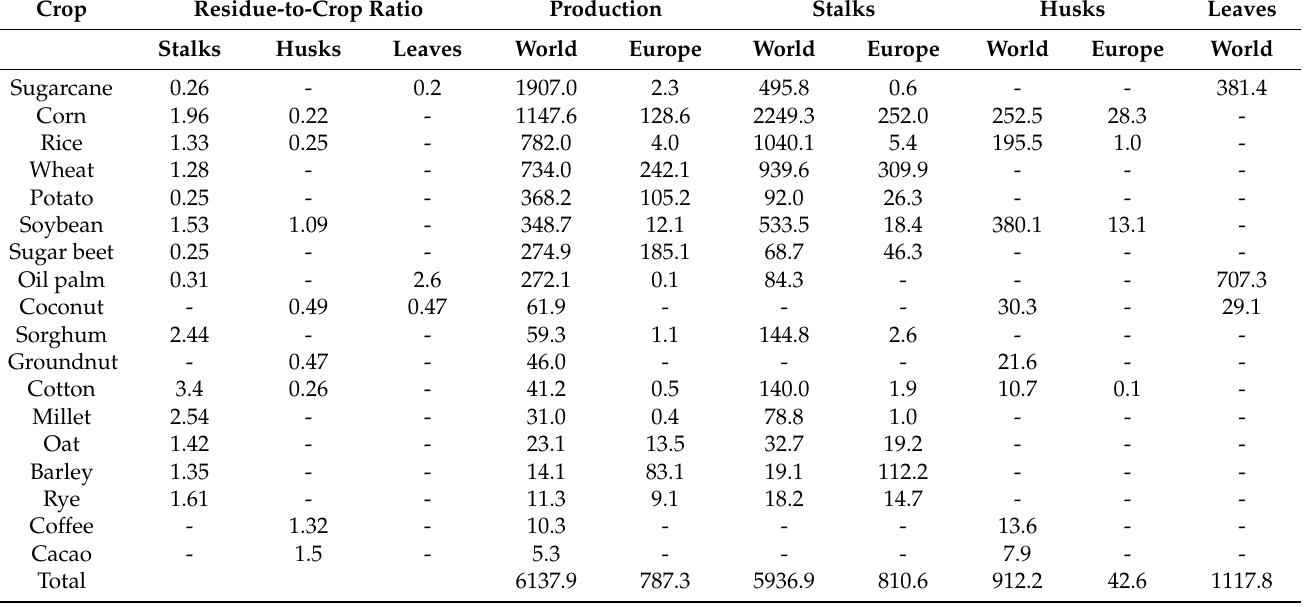
Table 2. Residue-to-crop ratio and amount of crop production in 2018 (million tons,